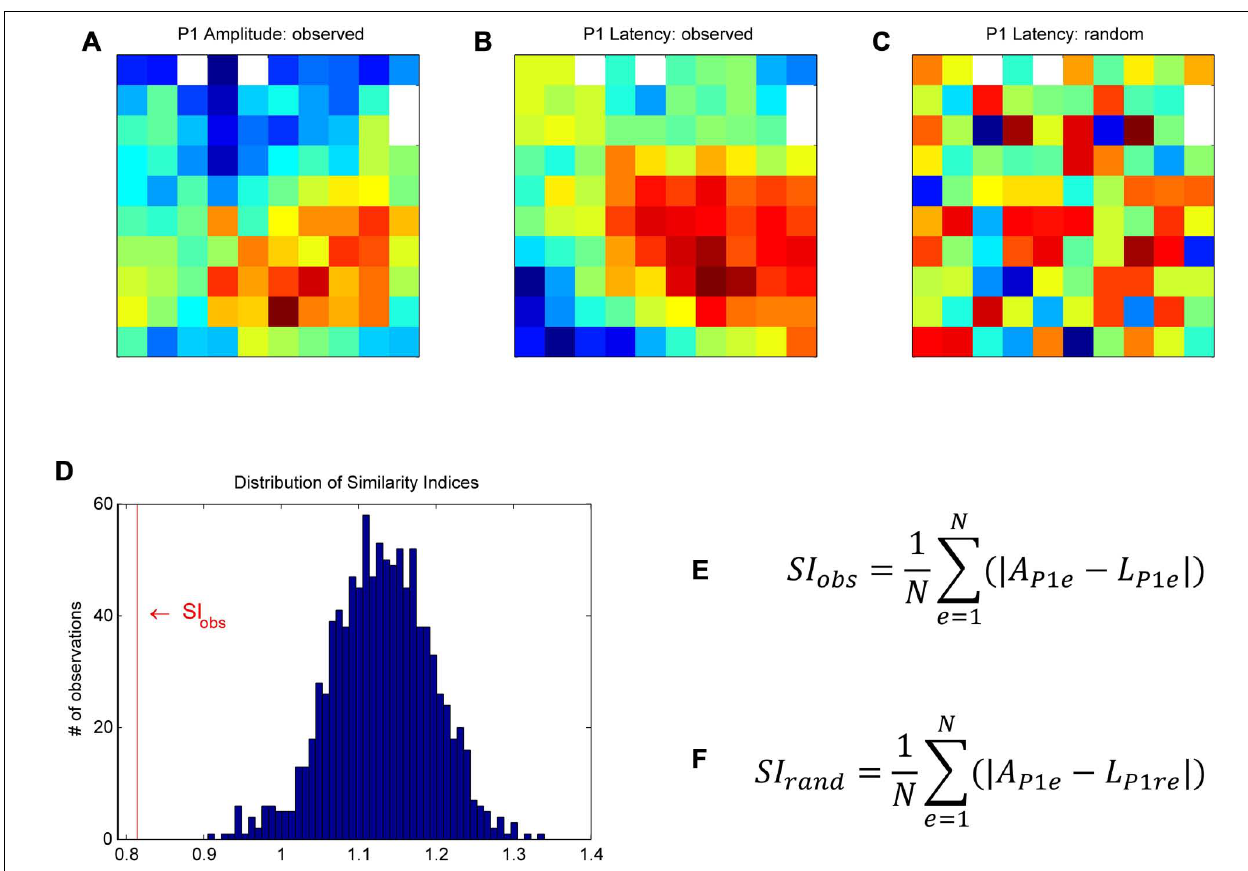
FIGURE 3 | Bootstrap procedure to assess whether the similarity between a given pair of maps could have occurred by chance (for more details, see Materials and Methods). As an example, we used the maps of the P1 peak amplitudes (A) and their latencies (B) . First, in order to homogenize the data to be compared between maps, we z -scored the data on each map individually.We then calculated a similarity index (SI) between the two maps of observations. At each electrode, we computed the absolute difference between the P1 amplitude and the P1 latency, and averaged these values across all electrodes to obtain the similarity index,